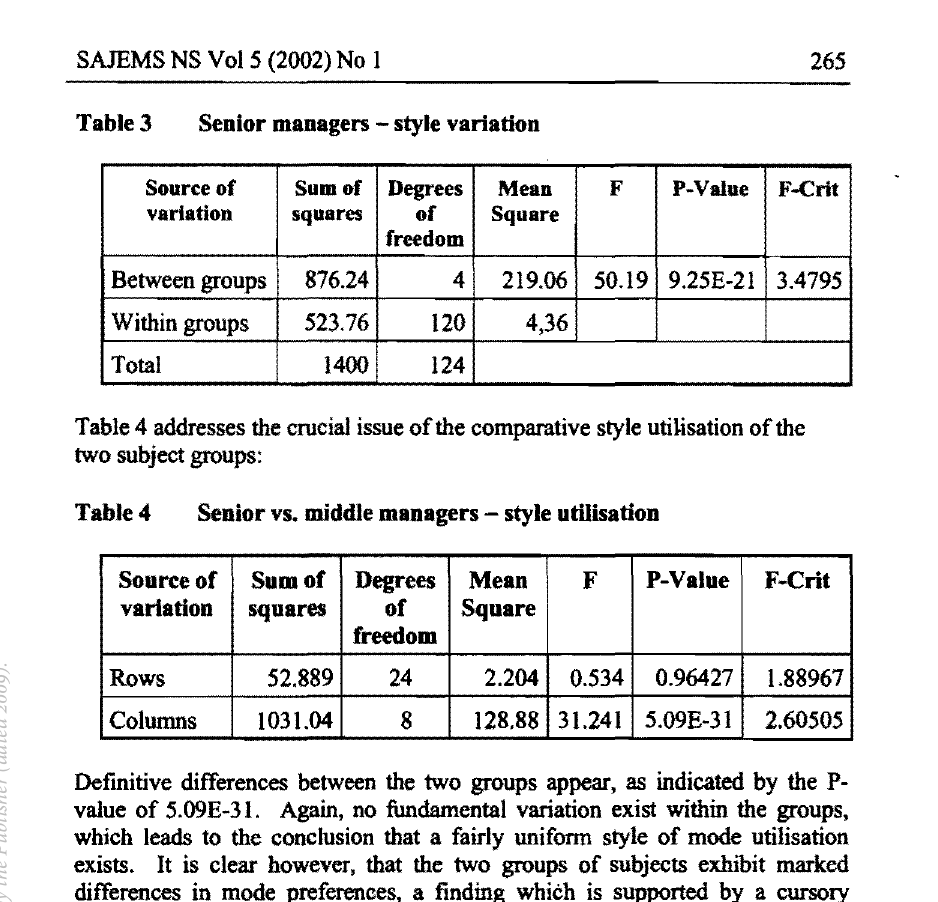
Senior managers - style variation